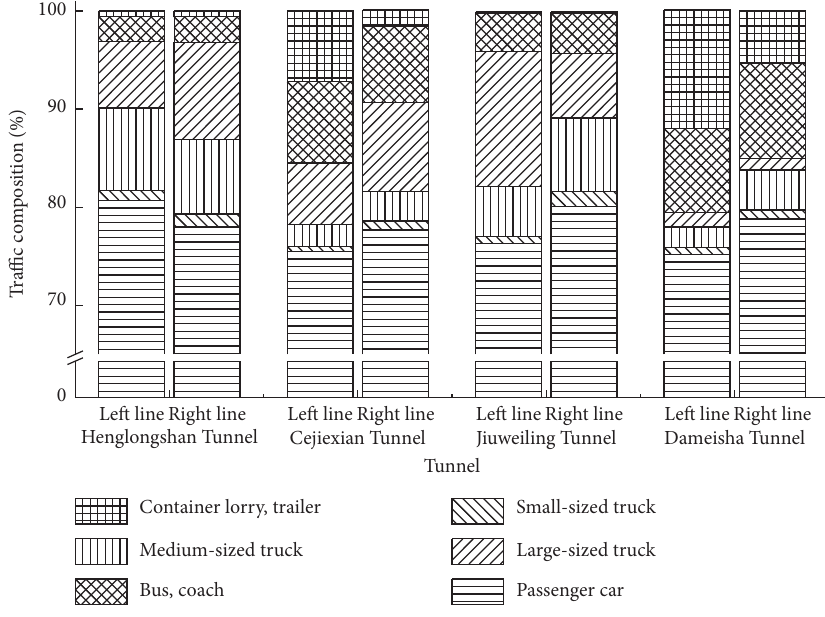
Figure 4: Traffic composition of the four tunnels.